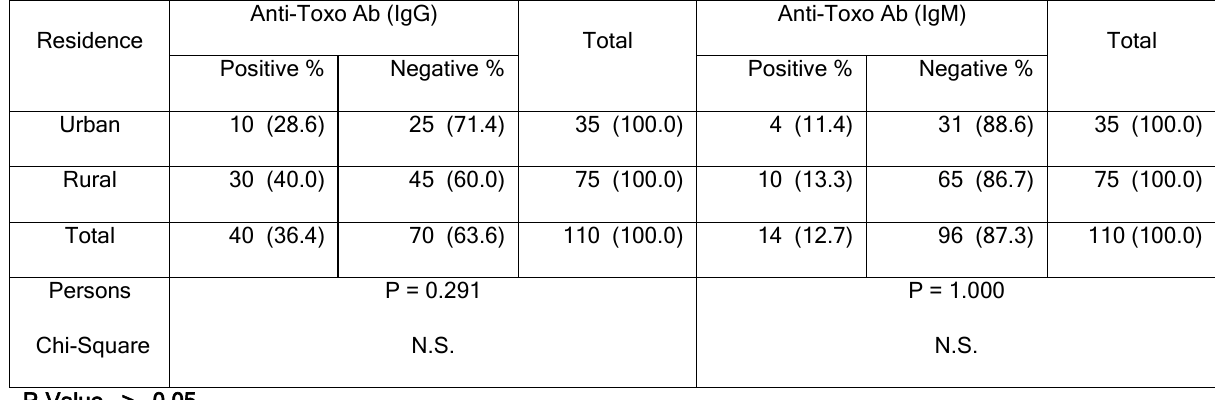
Table (4): Association between the seropositivity rates by ELISA (IgG, IgM) and the residence.